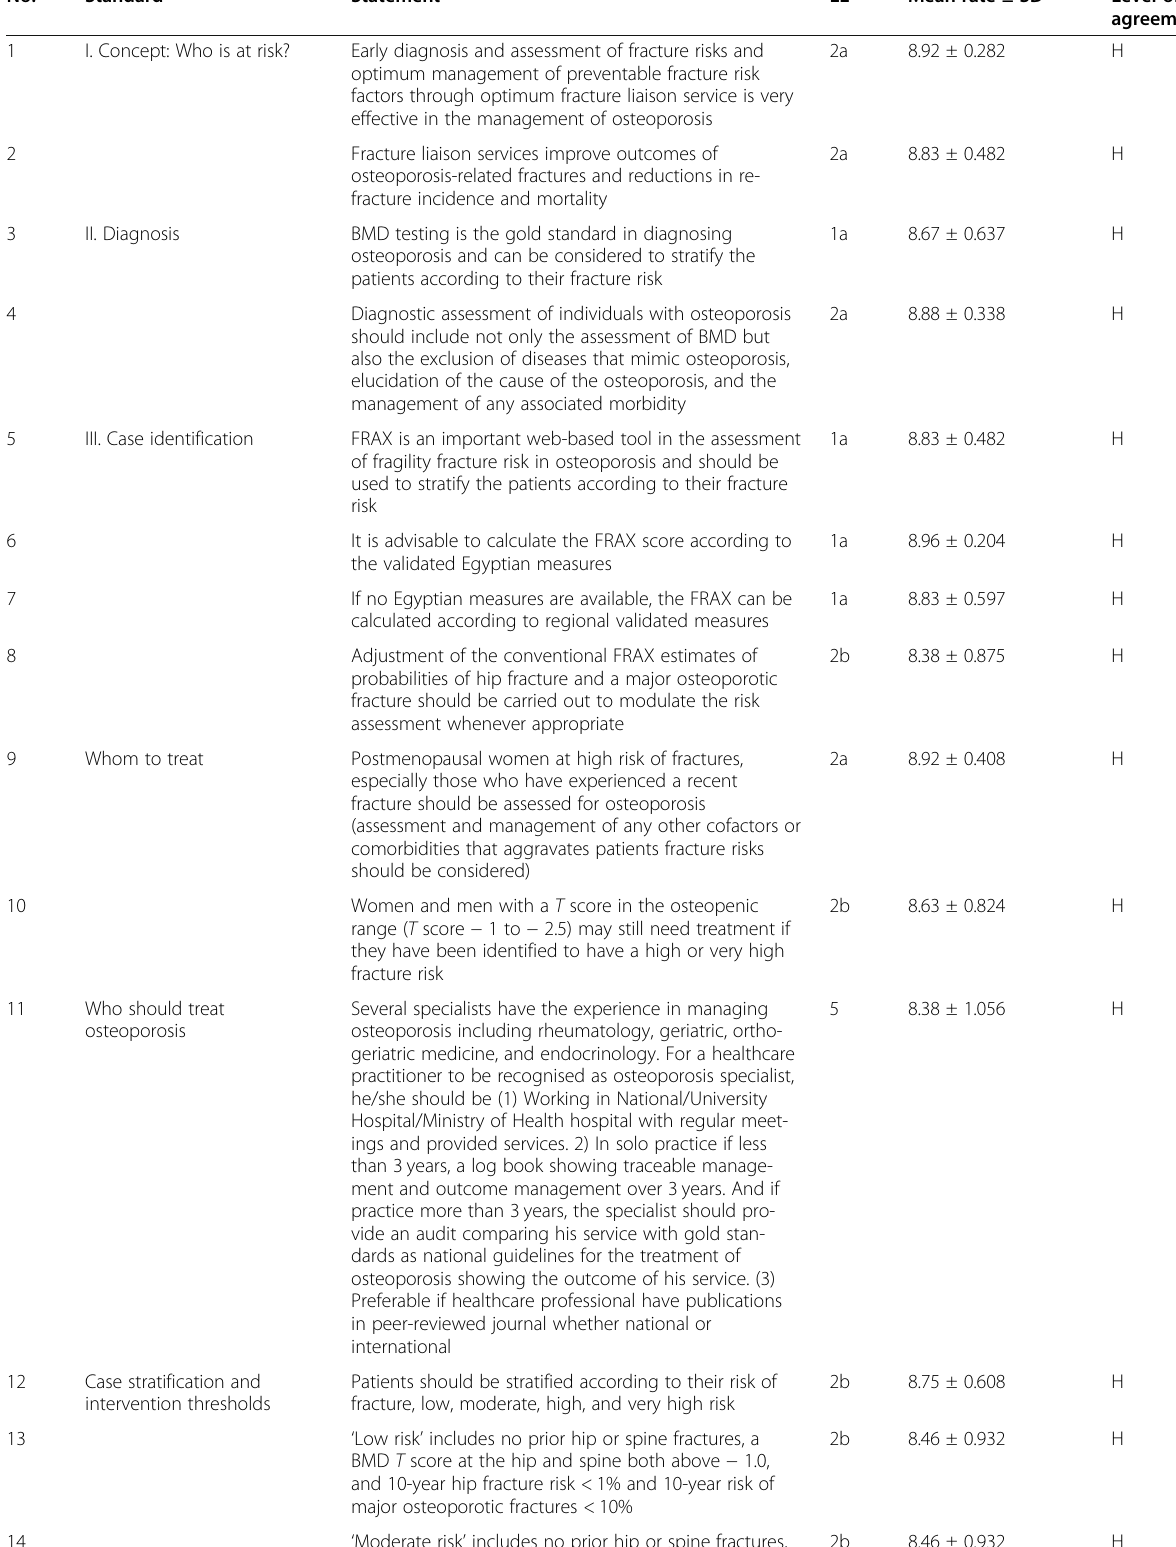
Table 2 Breakdown of statements of recommendations, its individual rank, and level of agreement